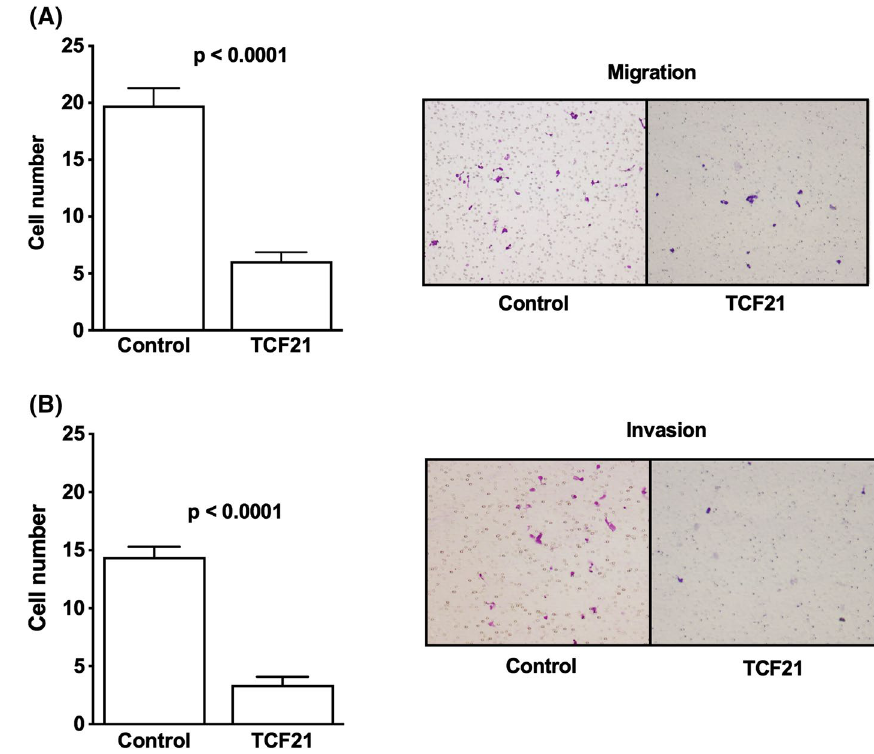
Fig. 3 Upregulation of TCF21 decrease ACC cell migration and invasion. A Migration of H295RpCMVMycPod1 cells (TCF21) was inhibited in rela- tion to respective controls and representative stained membranes; B Invasion of H295pCMVMycPod1 cells (TCF21) was inhibited in rela- tion to respective controls and representative stained mem- branes. The experiments were performed in triplicate and repeated three times. Magni- fication of membranes